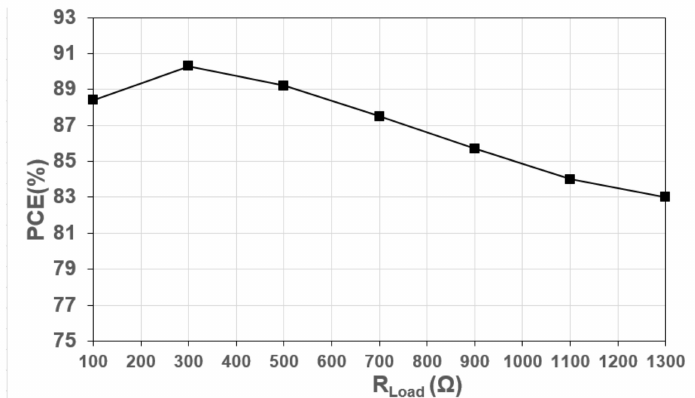
Figure 14. Measured PCE under different load